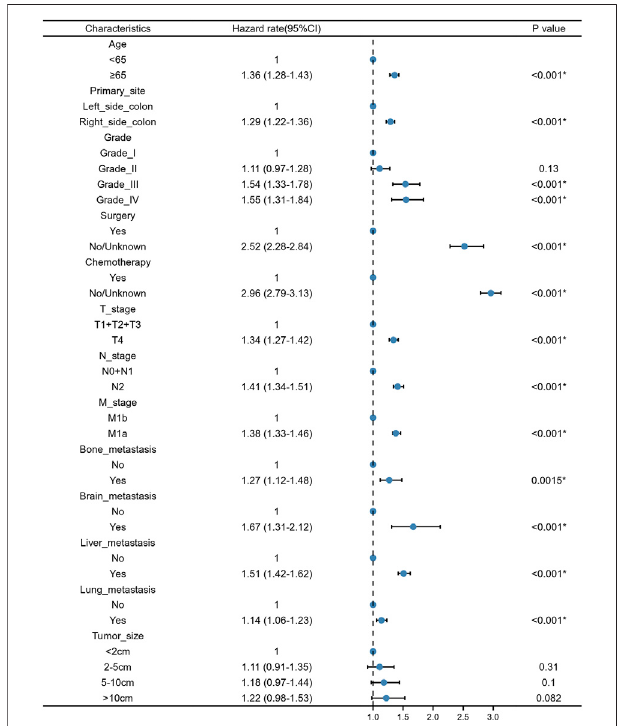
FIGURE 2 | Forest plot for multivariate Cox regression analysis of mCC patients in the training